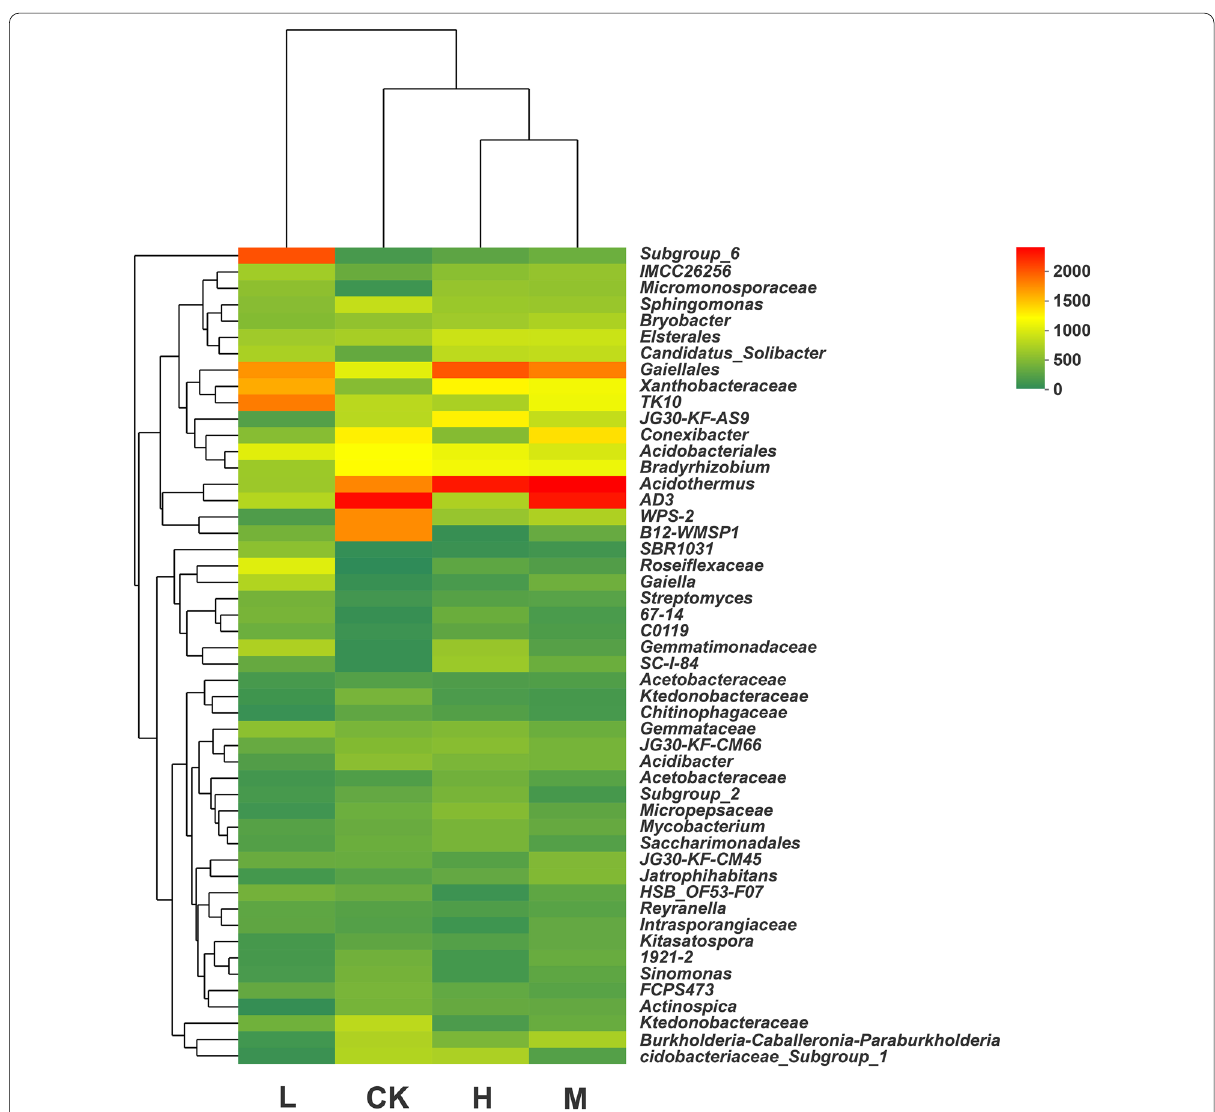
Fig. 4 Heatmap of four N application treatments with three replicates based on the relative abundances of the top 50 most abundant genera. A color zone represents relative abundance. H: high N application in the sugarcane soil (964 kg ha − 1 ), M: medium N application in the sugarcane soil (482 kg ha − 1 ), L: low N application in the sugarcane soil (96 kg ha − 1 ), CK: no N application in the sugarcane soil (0 kg ha − 1